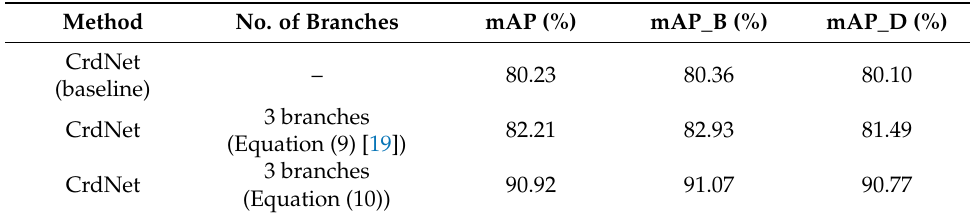
Table 6. Results of length-aware head based on LrNet. – indicates single branch.